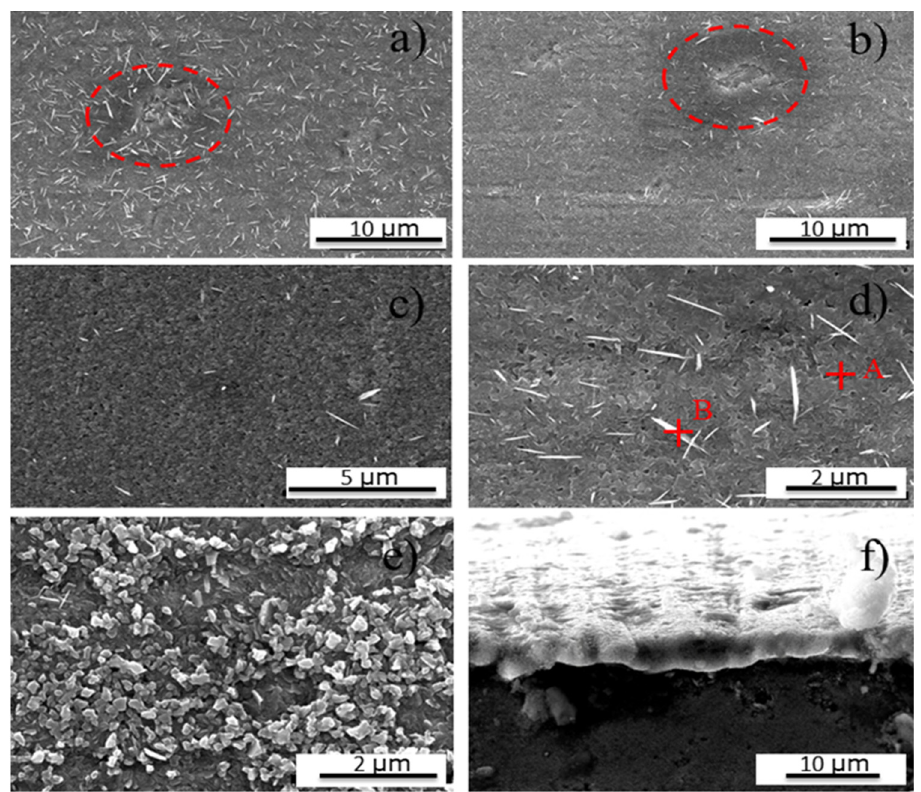
Figure 5. Scanning electron microscope (SEM) micrographs of the oxide produced on maraging 300 alloy, showing different heterogeneities, such as, ( a ) nodules, ( b ) holes, ( c ) porosity and ( d , e ) depicted on the surface; and ( f ) cross section of the oxide layer. Table 3. Energy-dispersive X-ray spectroscopy (EDS) analysis performed at two different points (as shown in Figure 5d).